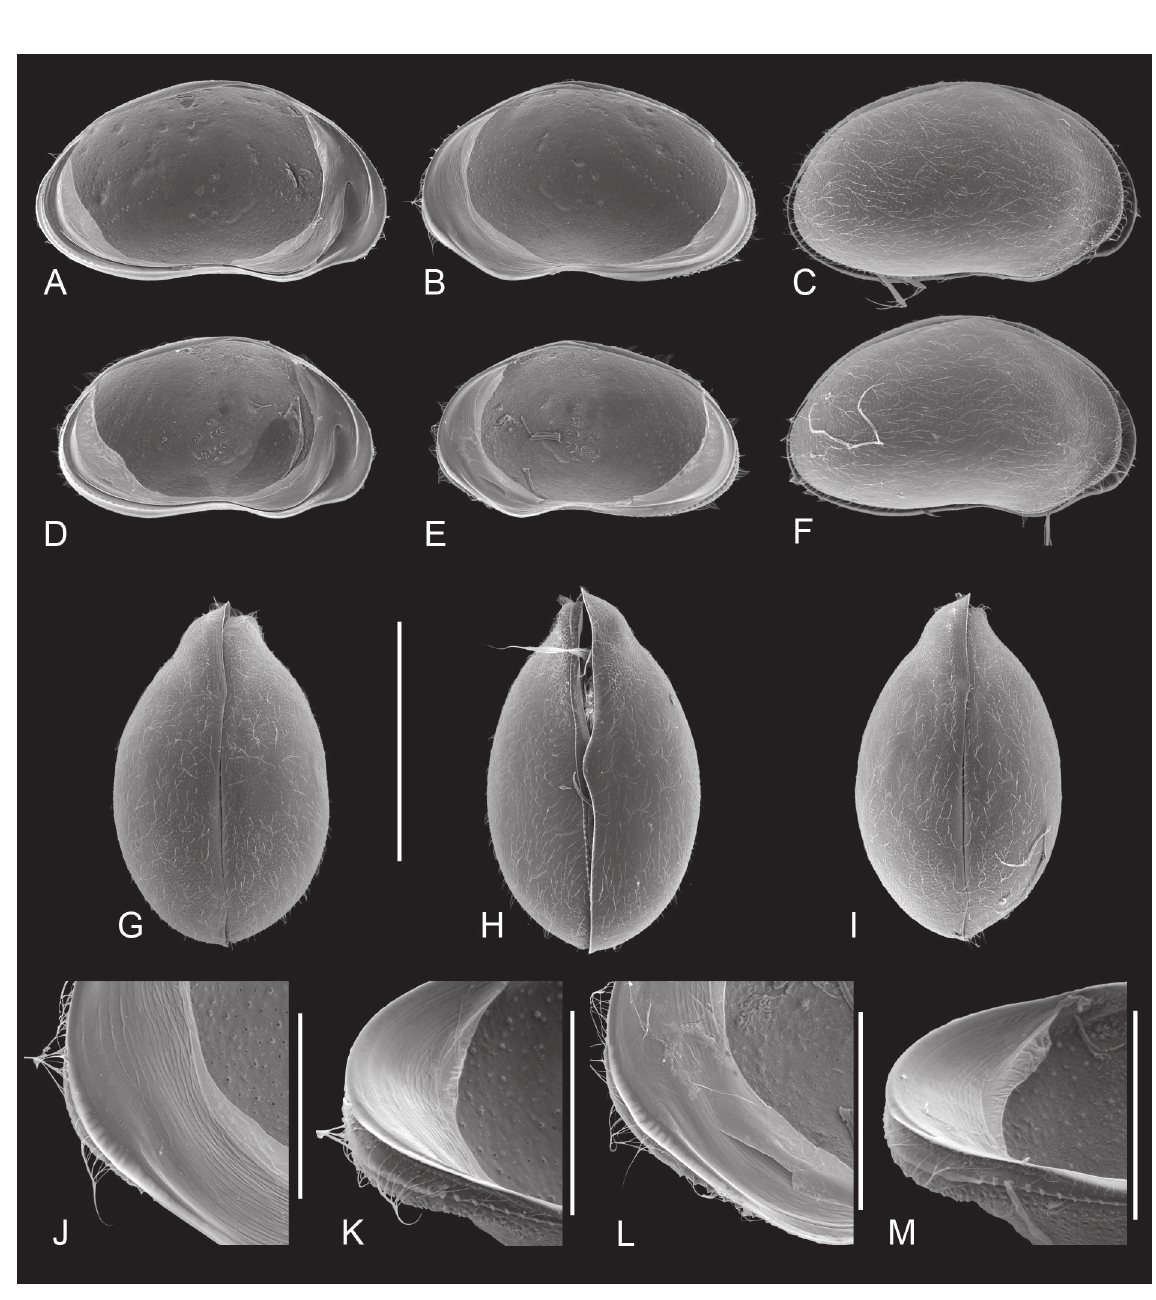
Fig. 14. Bennelongia hirsuta sp. nov., type specimens from type locality (styles rock, Ostr012D). A . ♀ allotype, LVi (WAMC52270). B . ♀ allotype, RVi (idem). C . ♀ paratype, CpRL (WAMC52277). D . ♂ holotype, lVi (WaMc52269). E . ♂ holotype, RVi (idem). F . ♂ paratype, CpRL (WAMC52272). G . ♀ paratype, cpD (WaMc52275). H . ♀ paratype, CpV (WAMC52276). I . ♂ paratype, CpD (WAMC52272). J . ♀ allotype, RVi, detail anterior (WAMC52270). K . ♀ allotype, RVi, detail anterior, tilted (idem). L . ♂ holotype, rVi, detail anterior (WaMc52269). M . ♂ holotype, RVi, detail anterior, tilted (idem). Scales: a-I = 1 mm; J-M = 300